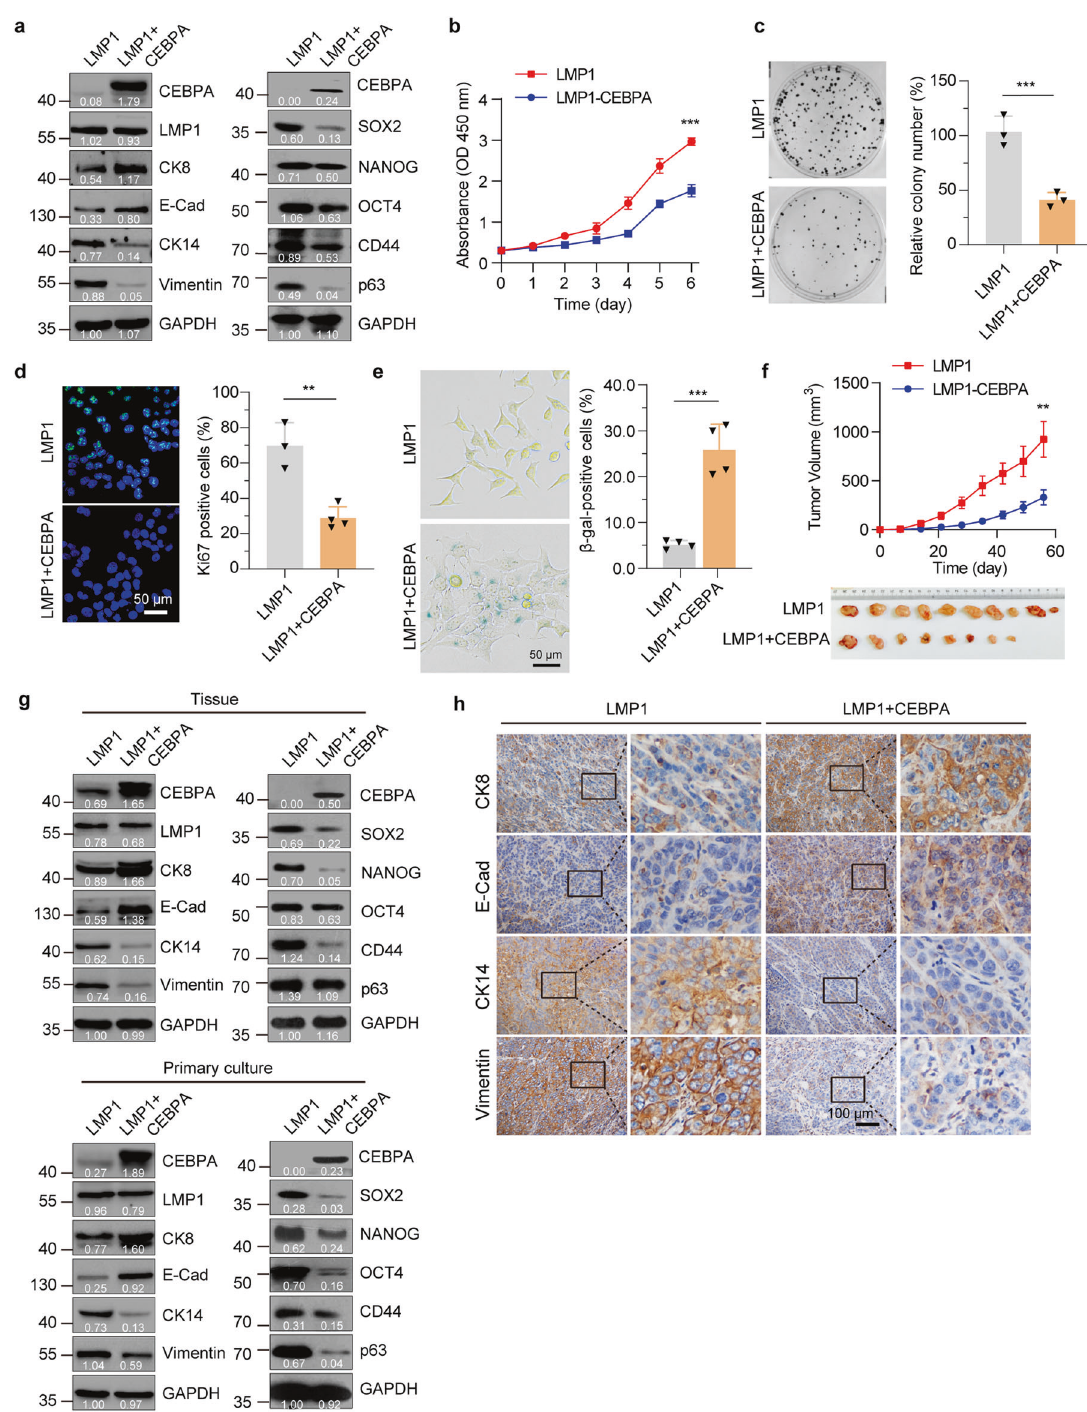
Fig. 4 CEBPA overcomes LMP1-induced dedifferentiation in NPC cells. a Western blot analysis with differentiation and stem-like markers in CNE1-TetOn-LMP1 and CEBPA-overexpressed CNE1-TetOn-LMP1 cells by 100 ng/ml Dox treatment for 48 hours. b Proliferation ability of CNE1- TetOn-LMP1 and CEBPA-overexpressed CNE1-TetOn-LMP1 cells was determined by CCK8 assay. c Colony formation in CNE1-TetOn-LMP1 and CEBPA-overexpressed CNE1-TetOn-LMP1 cells. d Immuno fl uorescence staining for Ki67 in CNE1-TetOn-LMP1 and CEBPA-overexpressed CNE1- TetOn-LMP1 cells. e SA- β -gal staining in CNE1-TetOn-LMP1 and CEBPA-overexpressed CNE1-TetOn-LMP1 cells. f CNE1-TetOn-LMP1 and CEBPA- overexpressed CNE1-TetOn-LMP1 cells were injected into nude mice subcutaneously. After continuous Dox administration, tumor volume was determined. g CEBPA, differentiation, and stem-like markers were analyzed by immunoblot in tumor tissue and primary cultured tumor cells. h IHC staining of differentiation markers in CNE1-TetOn-LMP1 and CEBPA-overexpressed CNE1-TetOn-LMP1 tumor tissues. Representative images are shown. Statistics ( b – f ), signi fi cance: ** P < 0.01, *** P < 0.001; two-tailed Student ’ s t -test